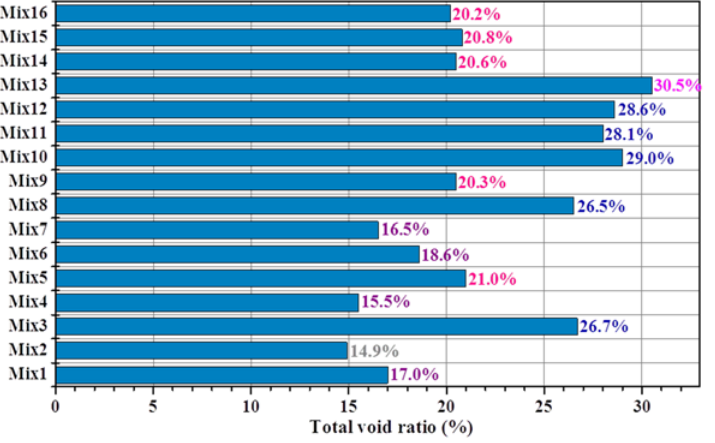
Figure 5. The total void ratios of porous mortar.